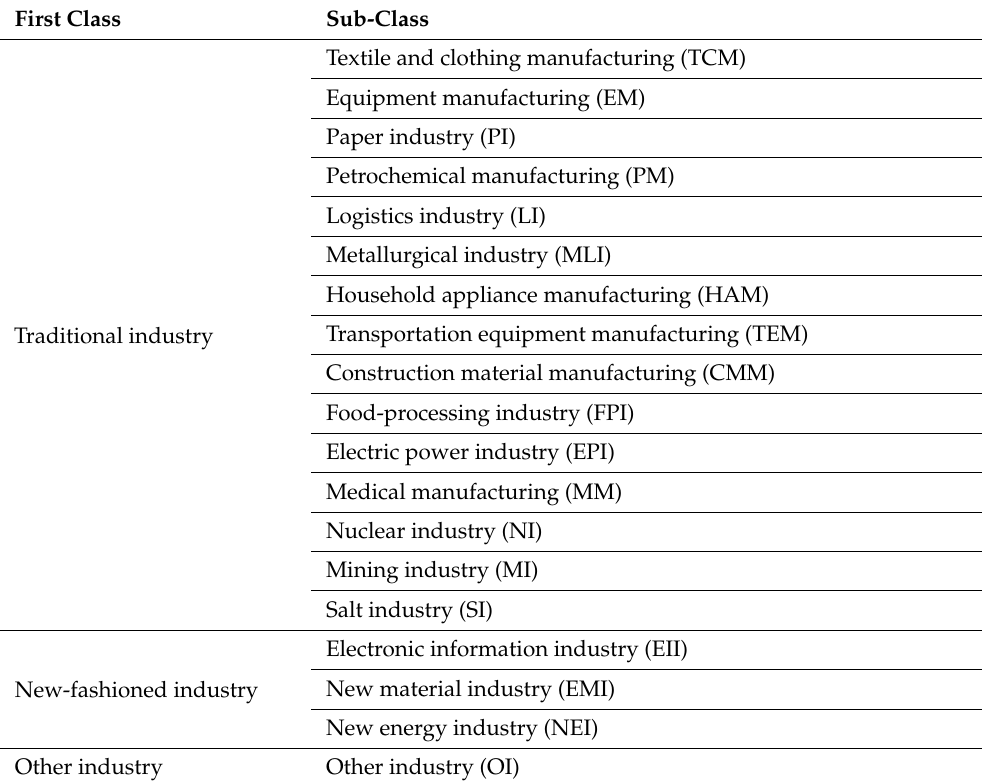
Table 1. Industrial structure classification system.